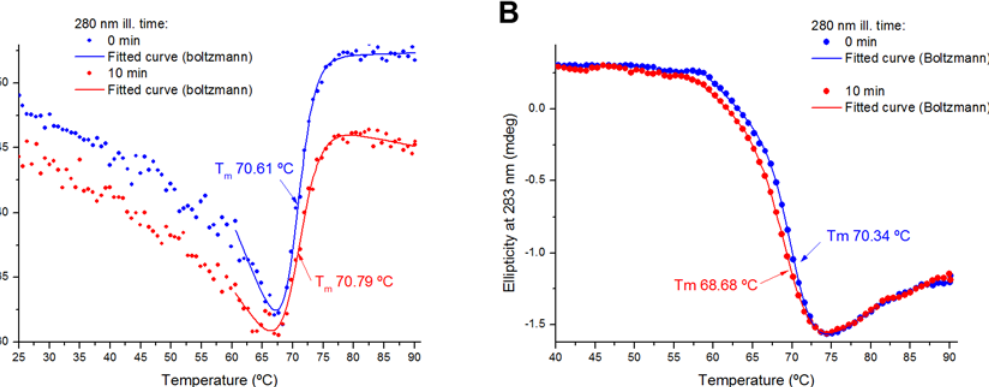
Fig 12. Circular dichroism thermal unfolding curves of human plasminogen. The circular dichroims thermal unfolding curves of a non-illuminated plasminogen sample (0 min 280 nm ill. time) or a UV illuminated plasminogen sample (10 min 280 nm ill. time) were obtained upon heating from 25 °C to 90 °C (1 °C.min -1 ). A- The ellipticity signal was constantly monitored at 206 nm. B- The ellipticity signal was constantly monitored at 283 nm. Both curves were fitted using a modified Boltzmann function (see Table 7). The melting temperature of the protein, which corresponds to the transition mid-point of each curve, was recovered from the fitting (parameter x 0) and is displayed for each